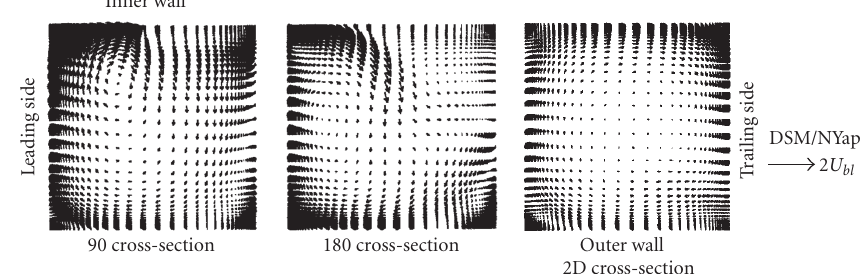
Figure 4: Predicted secondary flow